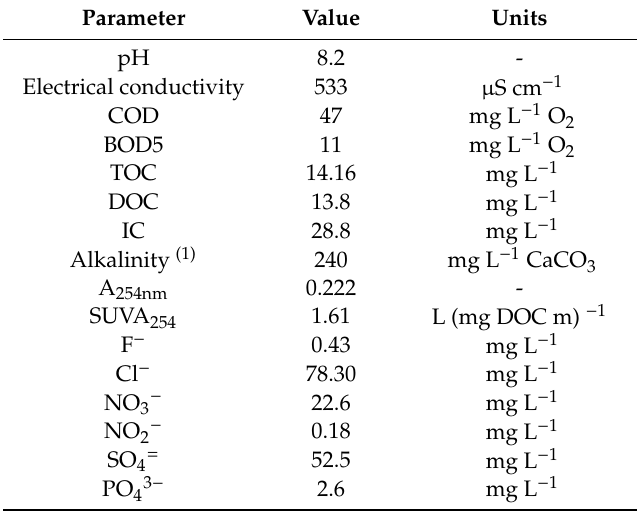
Table 1. Main characteristics of the secondary e ffl uent from the MWWTP of Badajoz (Spain).